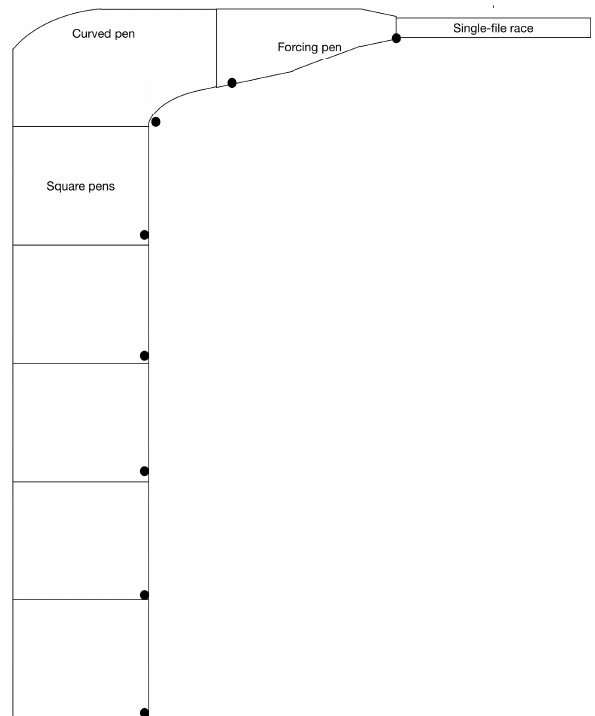
Figure 1. Diagram of the area observed at an Australian abattoir. Black circles indicate camera locations. Cameras were arranged in order from Camera 1 in the square pen at the bottom of the diagram through to Camera 6 at the curved pen, Camera 7 at the forcing pen, and Camera 8 at the single-file race.